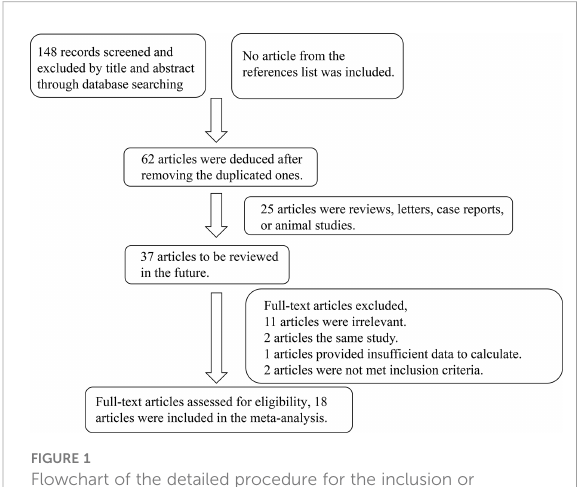
FIGURE 1 Flowchart of the detailed procedure for the inclusion or exclusion of selected